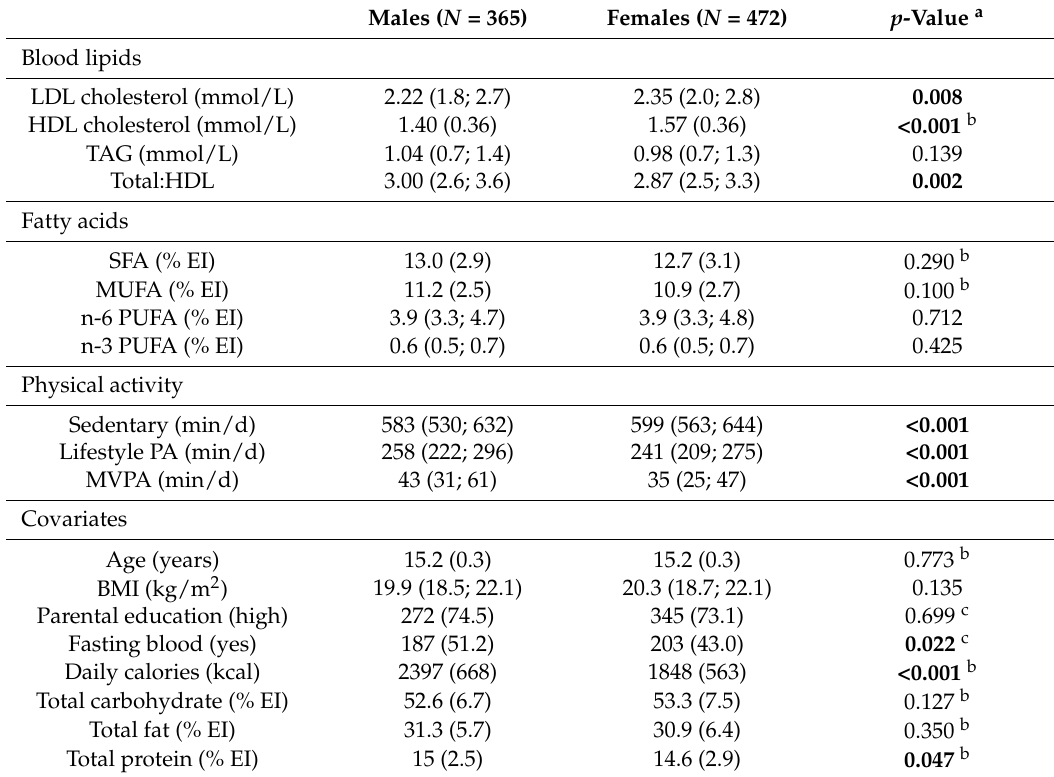
Table 1. Study population